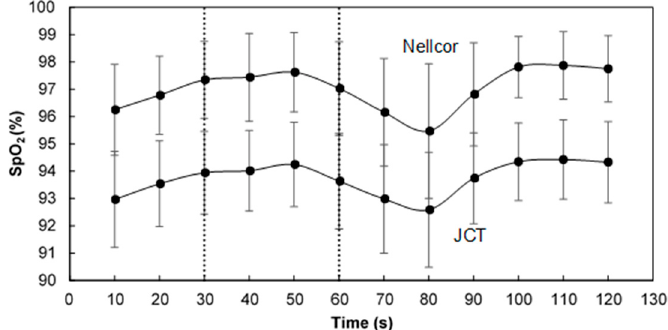
Figure 7. The mean SpO 2 value (and standard deviation) as a function of time for the two devices, obtained for the whole group of examinees.